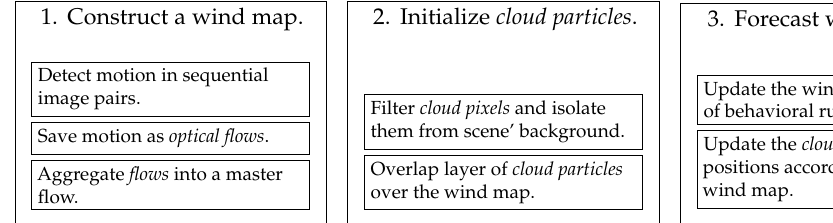
Figure 4. Processing workflow of the Dynamics